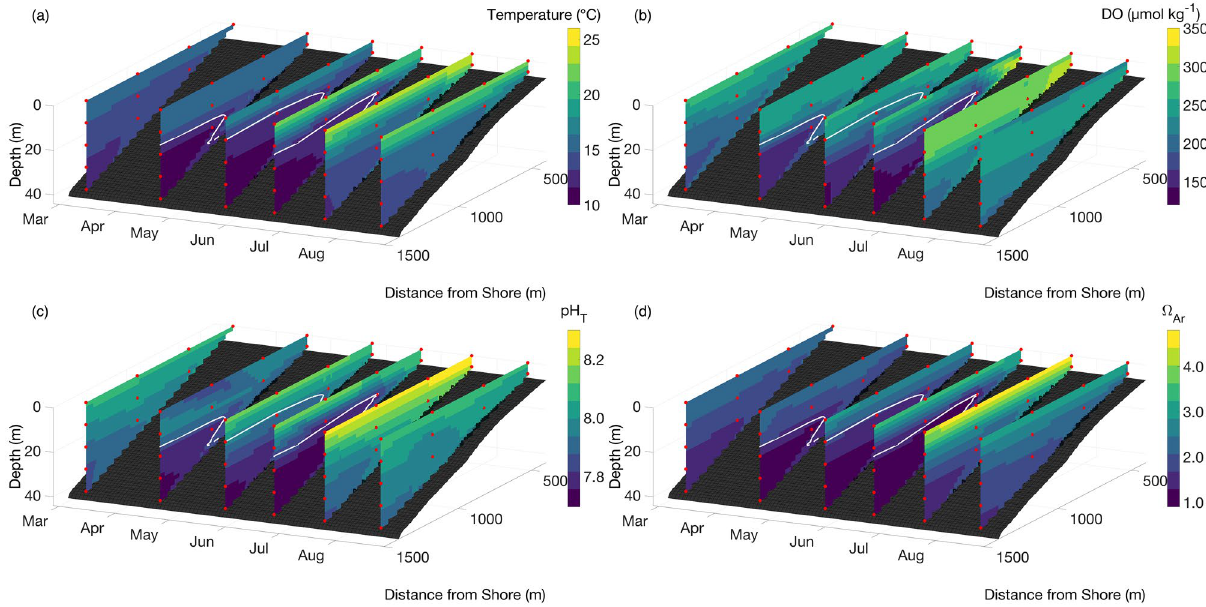
Figure 1. Contours of the spatial and vertical distribution of seawater temperature ( a ), DO ( b ), pH T ( c ), and Ω Ar ( d ) in the nearshore environment in La Jolla, CA, USA between March and August 2017 to highlight changes associated with the upwelling season. Each slice illustrates a single transect with red symbols representing discrete sample depths. The white contour line shows the 25.0 kg m −3 σ θ